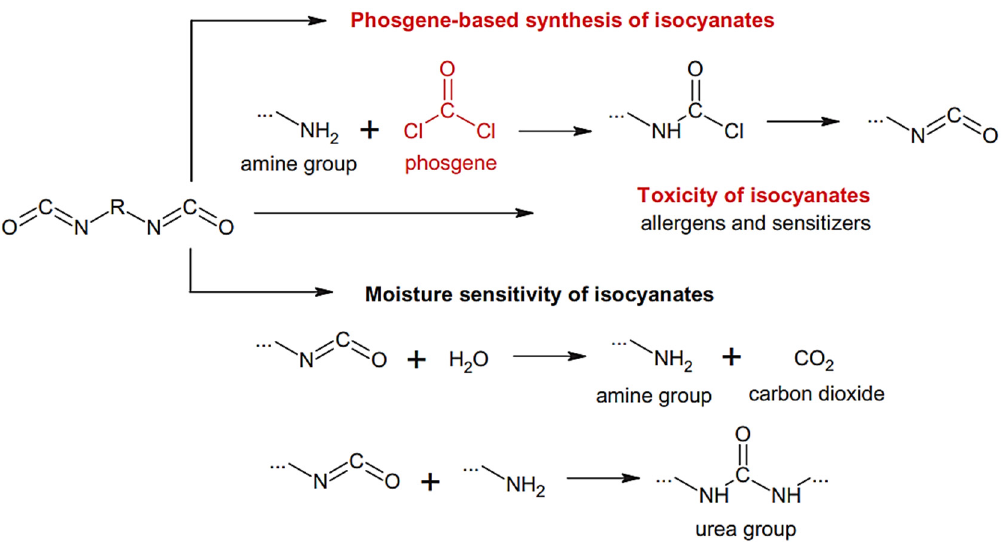
Figure 3. Synthesis of phosgene-based isocyanates. From reference [27].